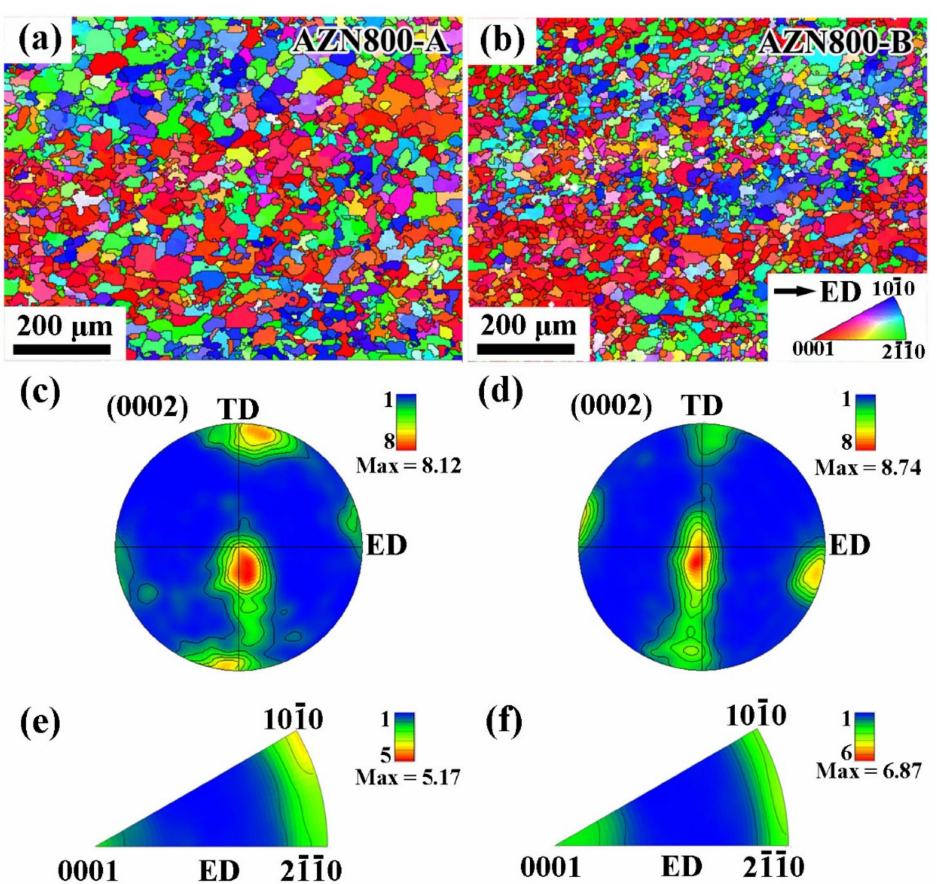
Figure 3. EBSD orientation (IPF-Z) maps and corresponding (0002) pole figures (PFs) and inverse pole figures (IPFs) of the extruded alloys: ( a , c , e ) AZN800-A, ( b , d , f )